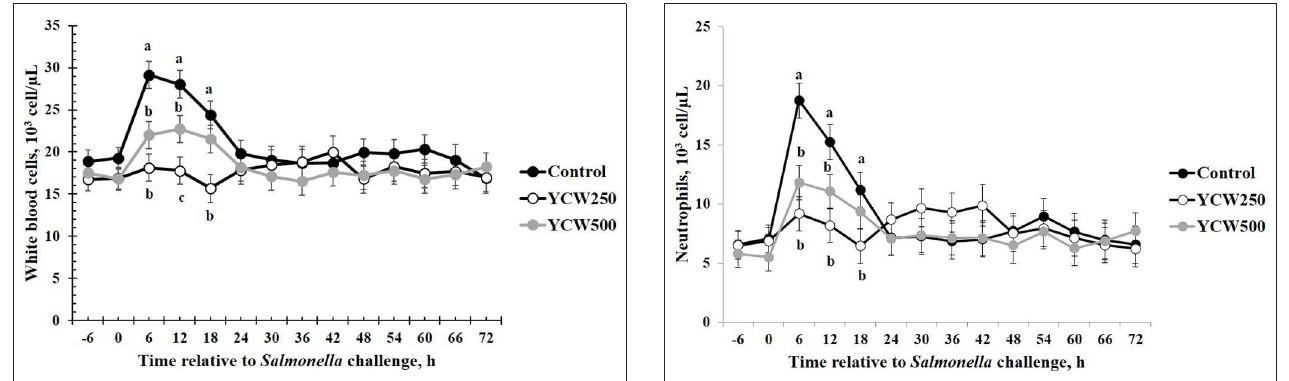
FIGURE 3 | White blood cell concentrations measured in pigs fed a control (Control) diet or supplemented with a yeast cell wall at 250 mg/kg (YCW250) or 500 mg/kg (YCW500), following administration of an oral Salmonella Typhimurium challenge on d 19. abc Treatments differ P < 0.02.